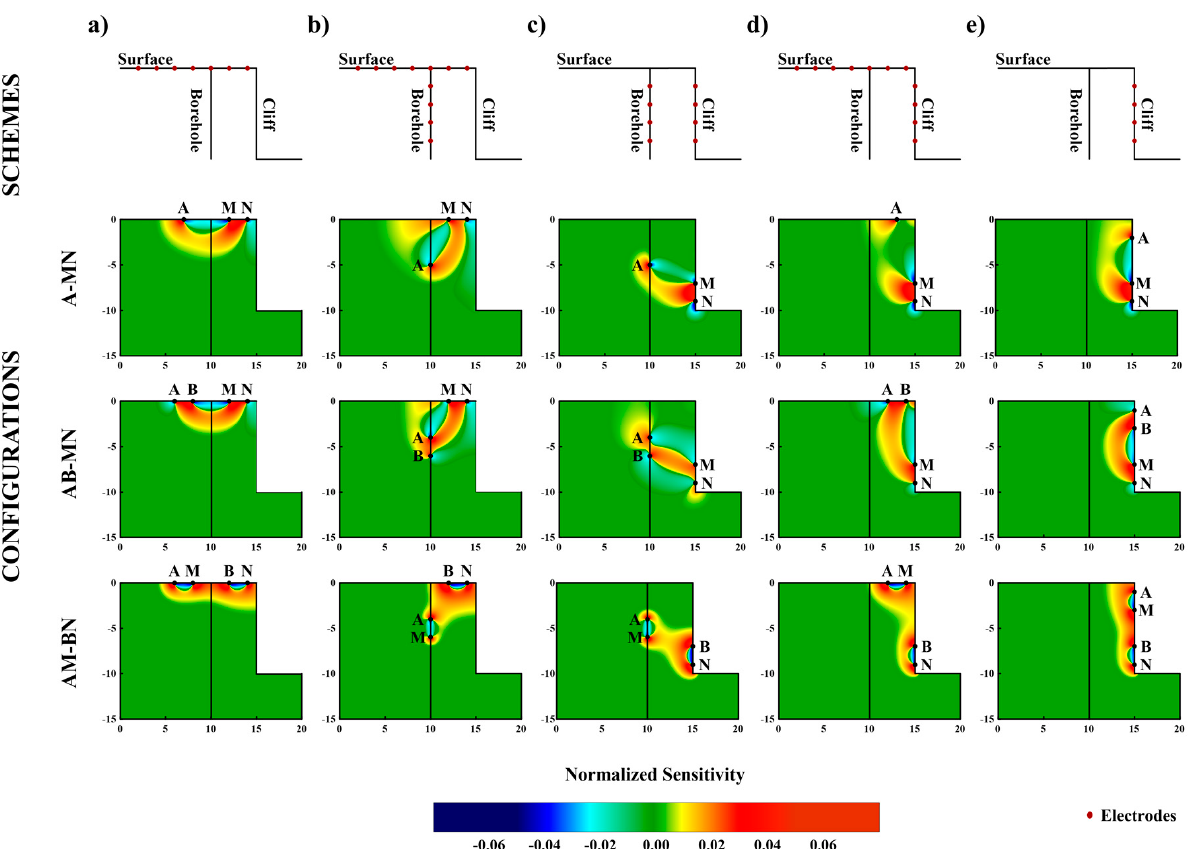
Figure 2. Electrode spatial distribution and sensitivity of five ERT schemes for grottoes. Columns ( a – e ) represent the surface ERT scheme, BS-ERT scheme, BC-ERT scheme, SC-ERT scheme, and cliff ERT scheme, respectively.